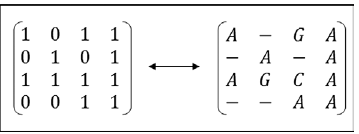
Figure 7. Equivalence Between Binary and Alphabetic Matrices.